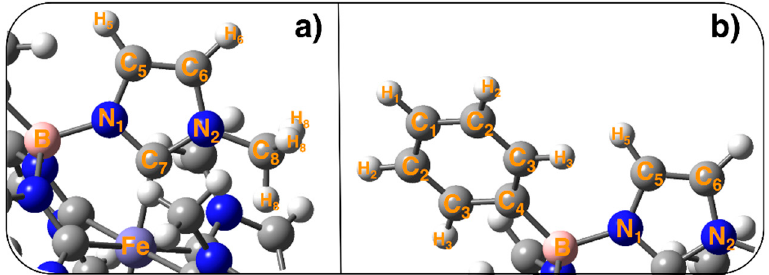
Figure 8. Atom types employed in all J OYCE parameterization performed for the ground states of the investigated iron complex.